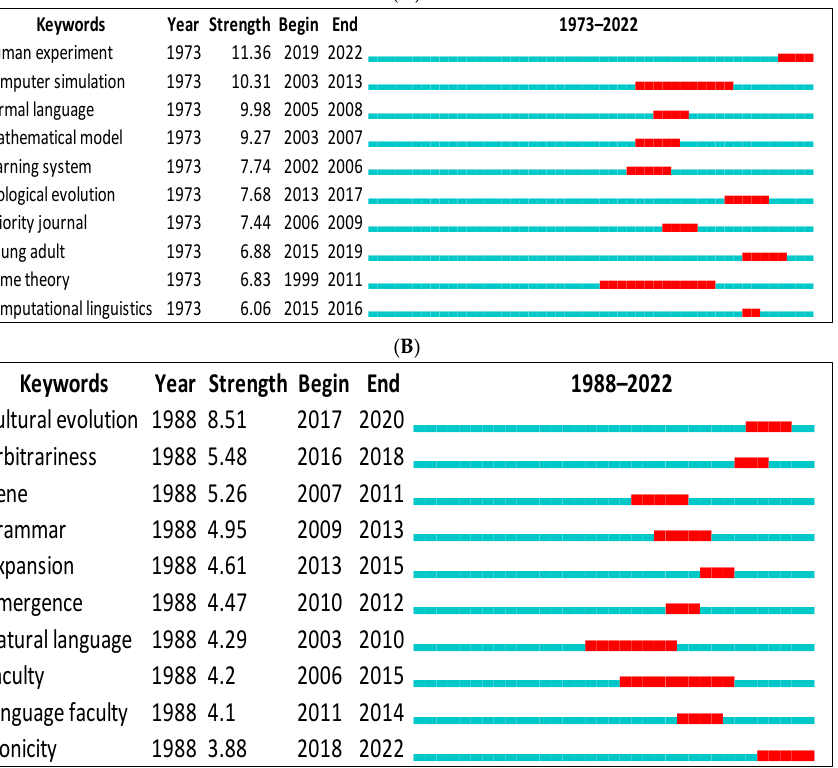
Figure 7. Knowledge production size in biolinguistics by author. ( A ) (Scopus), ( B ) (WOS), ( C ) (Lens).